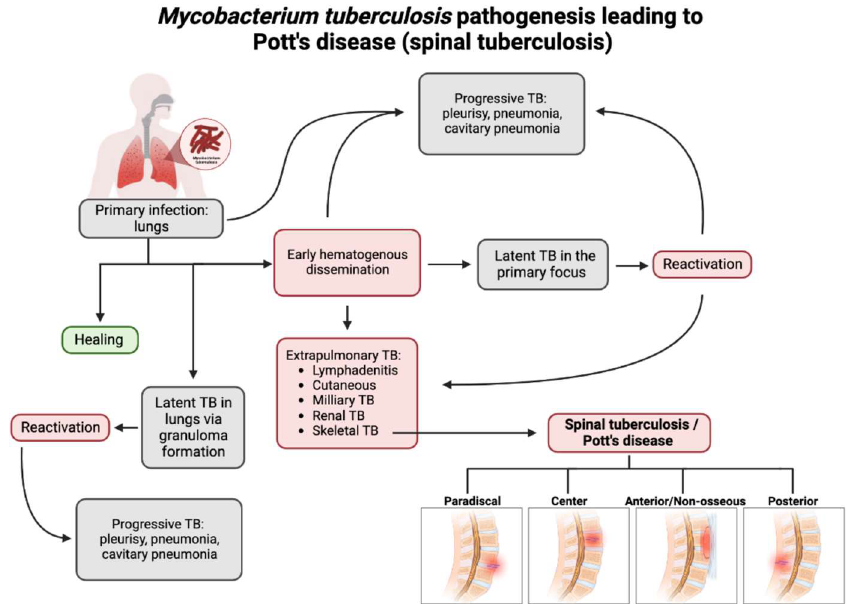
Figure 1. Flow chart depicting the pathogenesis of Pott’s disease. From primary infection, spinal tuberculosis may develop from hematogenous dissemination from the primary infection site and spread to an extrapulmonary site, one of which is the involvement of the skeletal system and, thus, the spine. Following this infection of the spine, spinal TB could present in four major presentations: paradiscal (involves the subchondral space and disc degeneration), central (stems from the center of the vertebral body), anterior/non-osseous (abscess formation between the spinal column and the anterior longitudinal ligament, often spanning multiple segments, sparing bone/disc involvement), and posterior (the infection seeds in the neural arch and posterior aspects of the vertebra). This leads to a compromise and the destruction of the spinal column and causes the classic and atypical presentations of spinal TB/Pott’s disease [3,18−20].